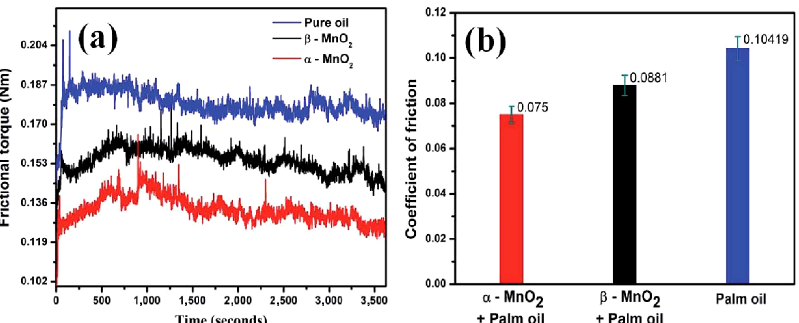
Fig. 3 (a) Frictional torque with respect to time observed using four-ball test technique, (b) COF of pure palm oil, β -MnO 2 -added palm oil, and α -MnO 2 -added palm oil.